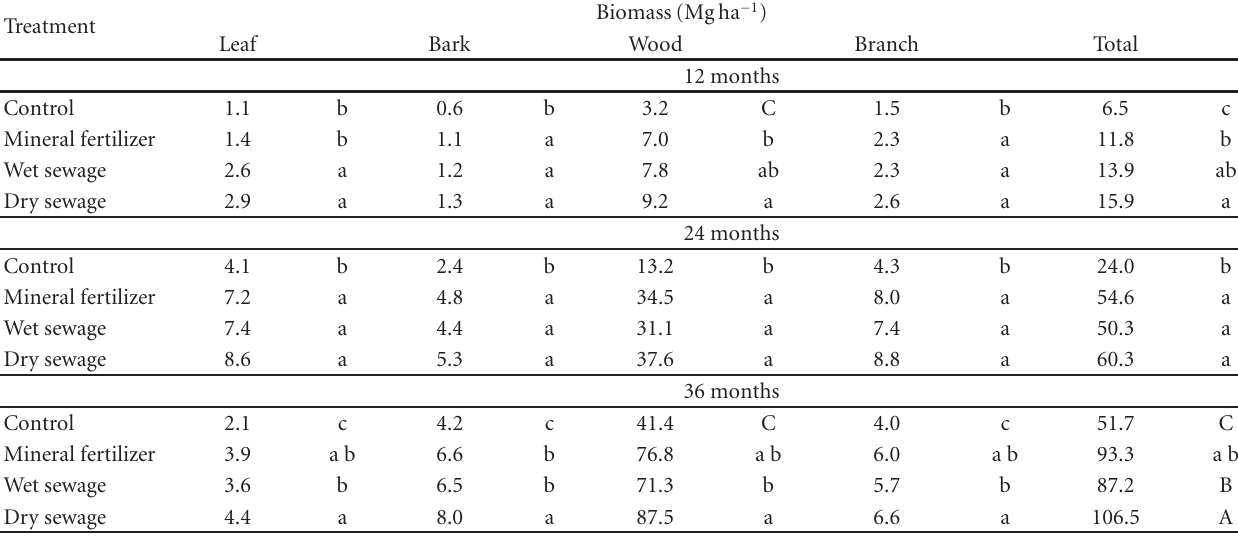
Table 4: Aboveground tree biomass accumulated at 12, 24, and 36 months after